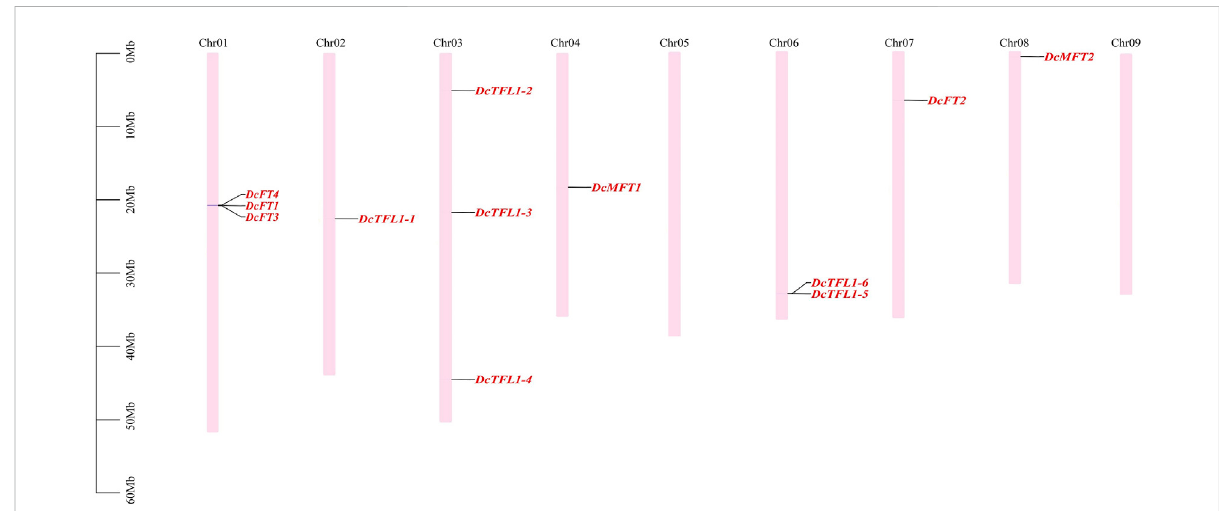
FIGURE 2 Distribution of PEBP family genes on carrot chromosomes. The names of 12 carrot PEBP genes are shown to the right of each chromosome. Gene positions and chromosome size can be measured using the scale on the left of the fi gure in mega bases (bp).